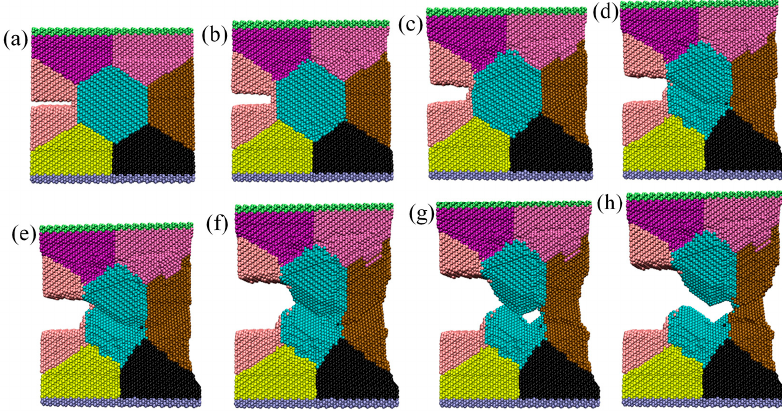
Figure 2. Process of crack propagation in the polycrystal nickel at the strain rate of 2 × 10 8 s − 1 : ( a ) ε = 0;